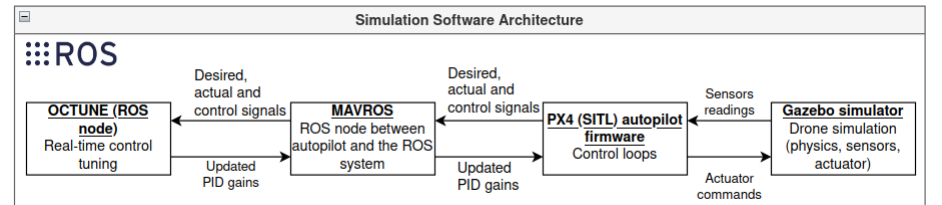
Figure 4. Abstract of the software architecture used in the simulations. Bold and underlined text represent software packages that are explained in Section 5.1.